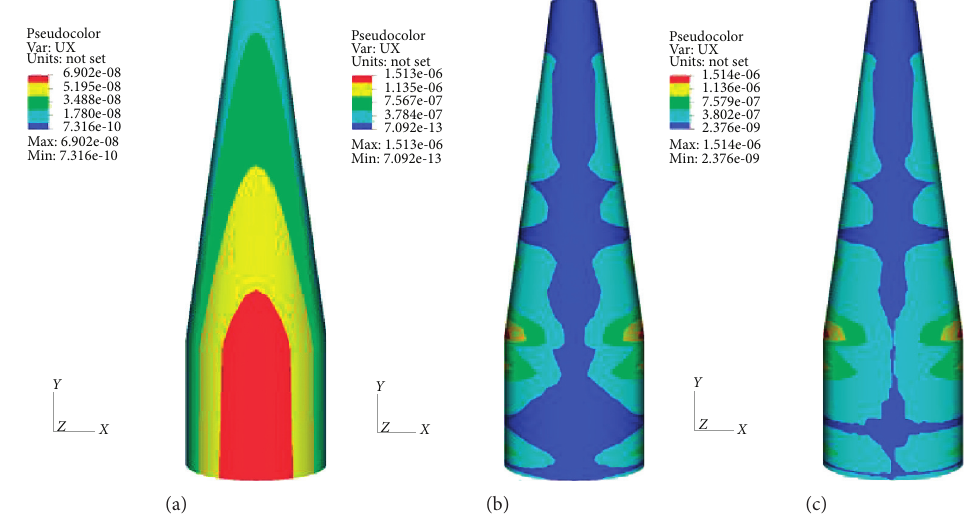
Figure 16: The RMS displacement fringes of reentry vehicle. Table 2: Computing time statistics for different solution stages.